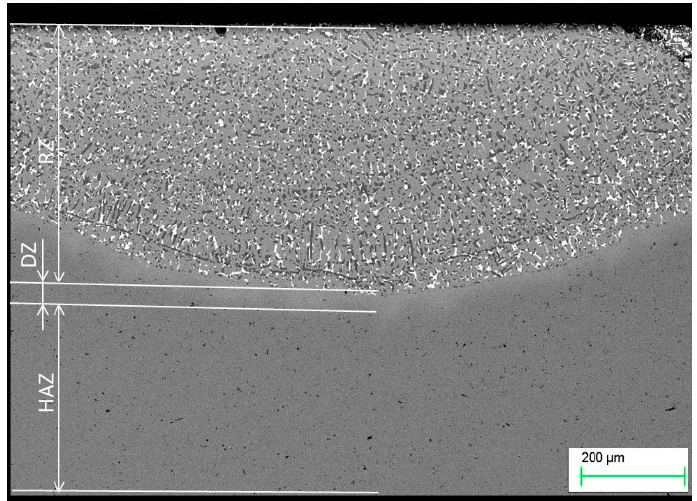
Figure 4. Microstructure of copper after Ag alloying. RZ = re-melted zone, DZ = diffusion zone, HAZ = heat affected zone.